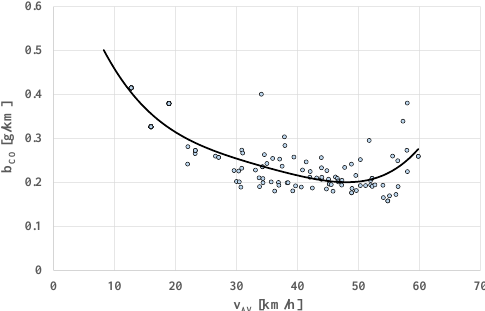
Fig. 1. Example characteristics of exhaust emissions – relation between the average specific distance emission of carbon monoxide and the average vehicle